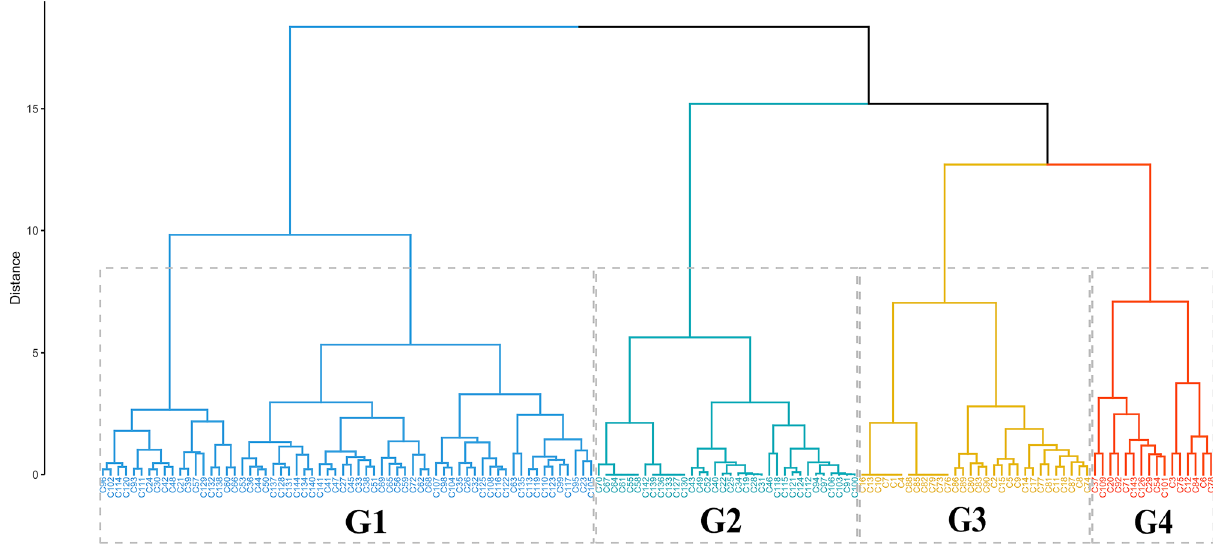
Figure 4. Cluster analysis of treatments using Euclidean distance and Ward’s hierarchical